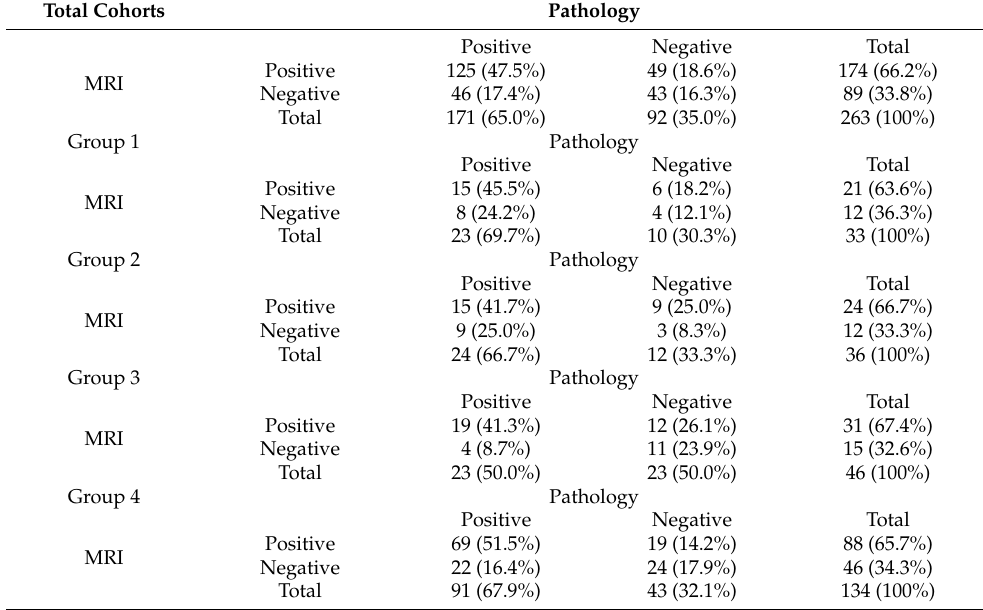
Table 3. The analysis of sensitivity, specificity, and accuracy for assessment of myometrial invasion in